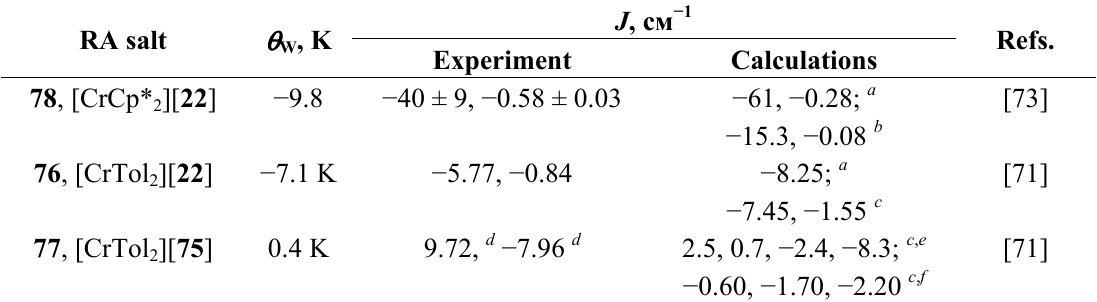
Table 9. Experimental and calculated parameters ( J ) of the pair exchange interactions and ) for a series of heterospin RA Weiss temperatures ( θ W